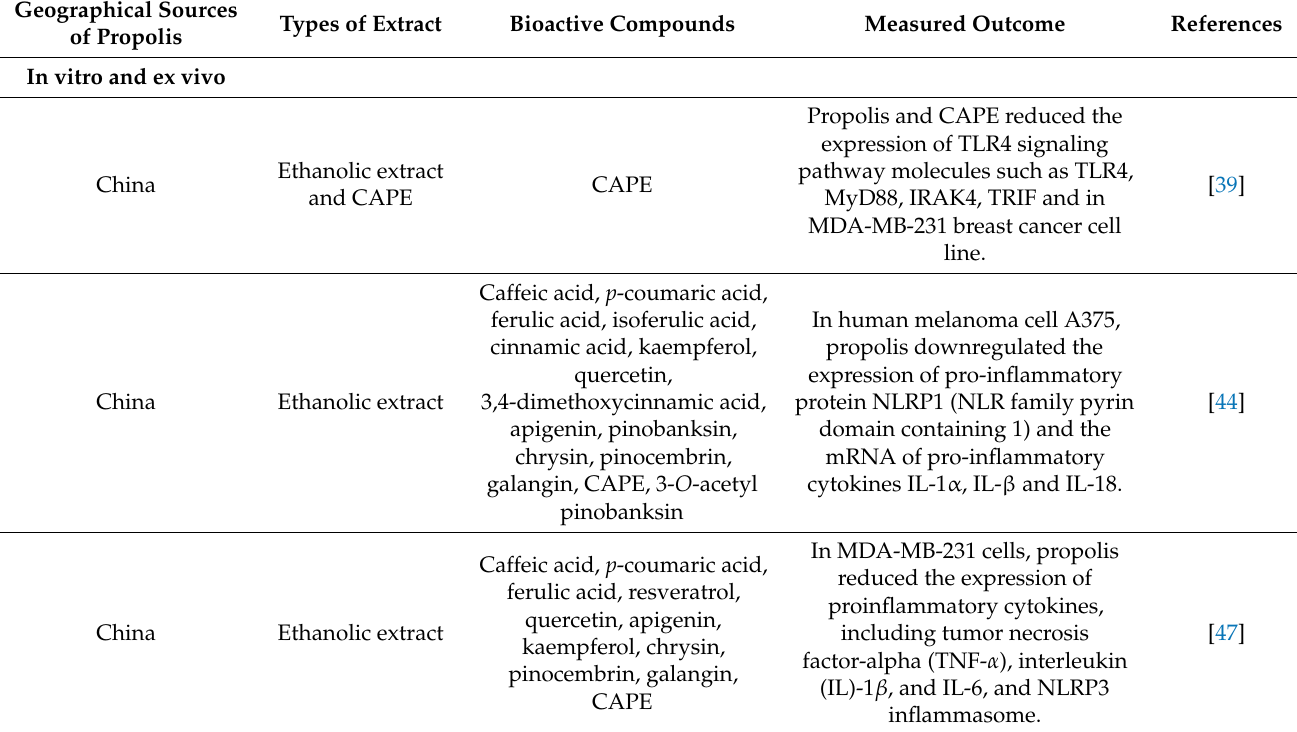
Table 2. Anti-inflammatory properties of propolis in